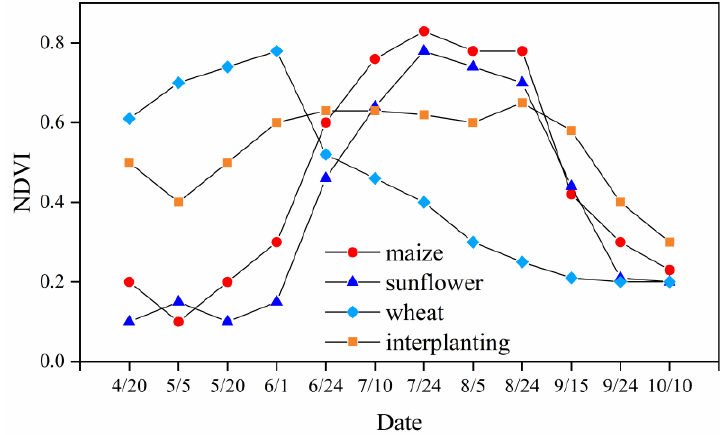
Figure 3. Characteristic curves of the NDVI in the typical croplands.